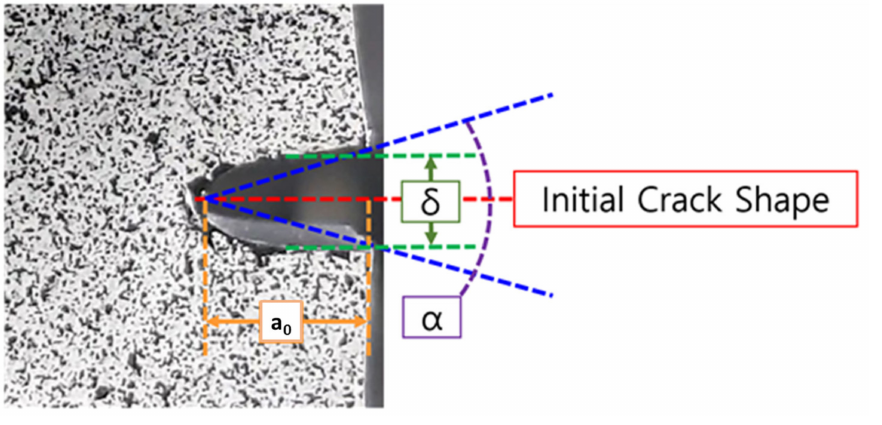
Figure 3. Crack tip opening angle